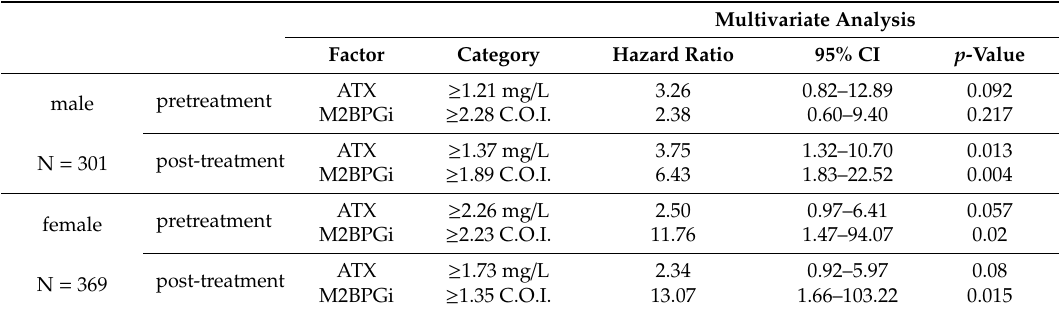
Table 1. Factors associated with post-SVR HCC